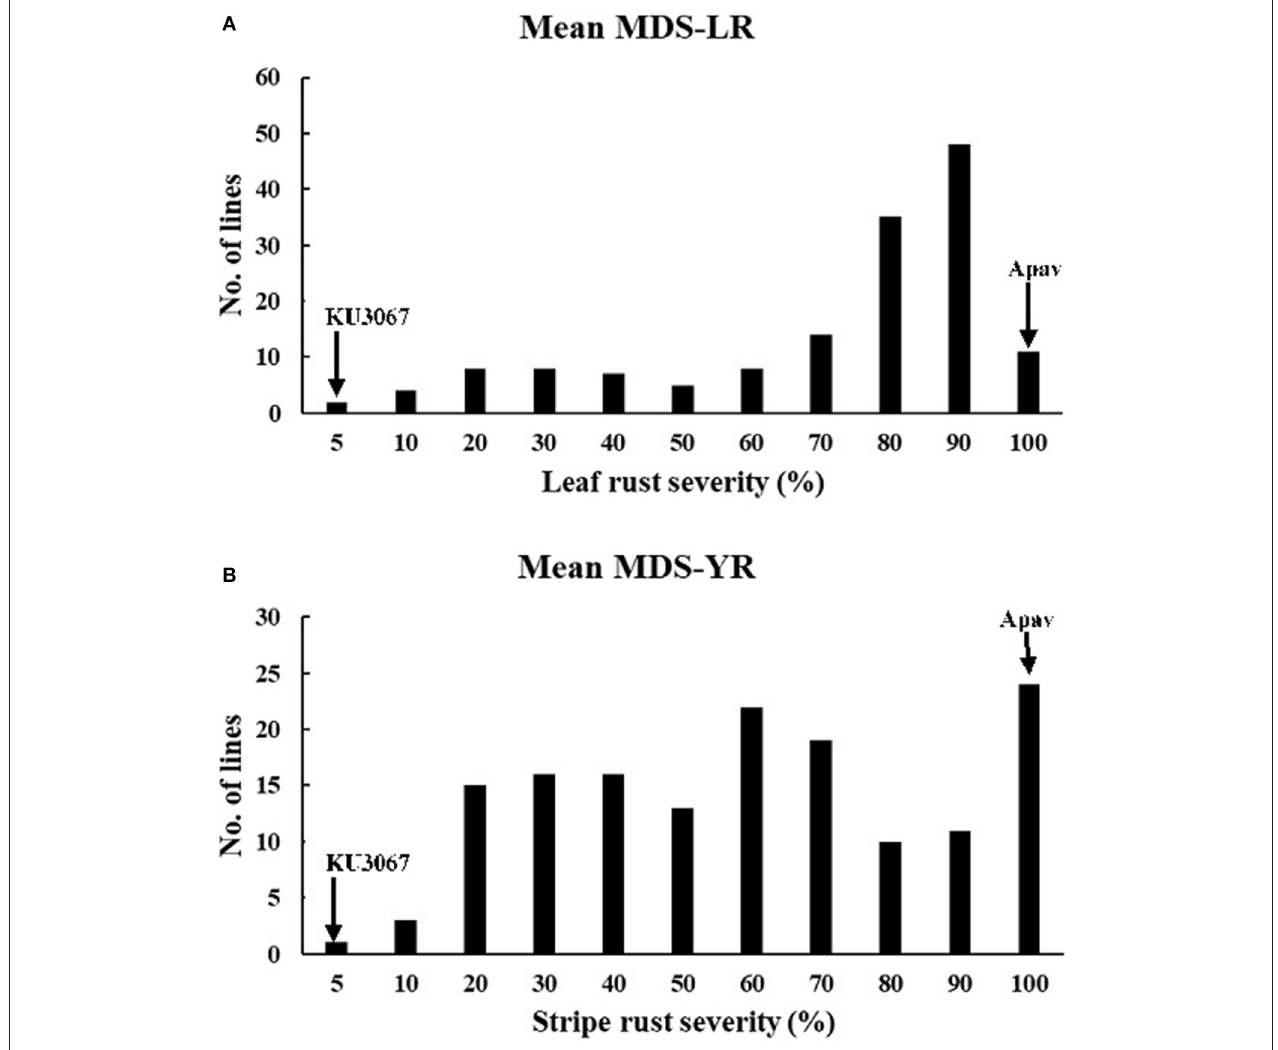
FIGURE 1 | Frequency distributions of KU3067/Apav BILs lines for mean LR (A) and YR (B) MDS in the field conditions. Mean values for the parents, KU3067 and Apav, are indicated by arrows.